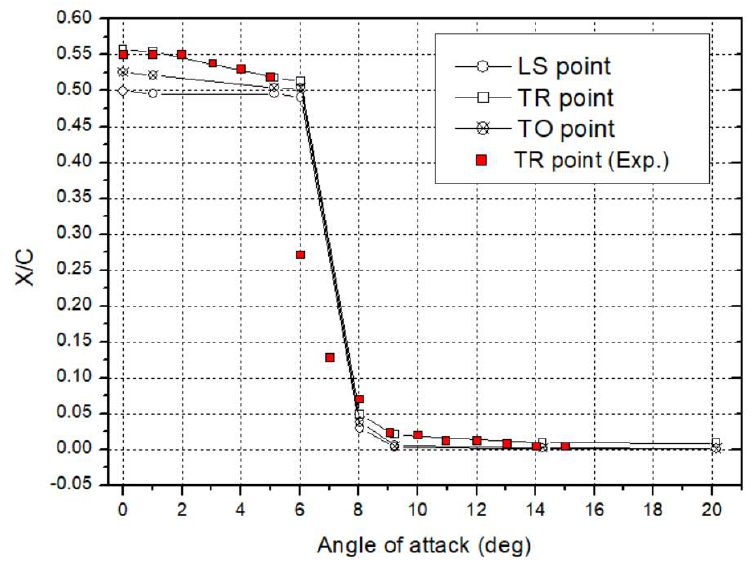
Figure 9. Movement of LS, TR, and TO points on the suction airfoil surface with increasing AoA. The red squares represent experimental data points.